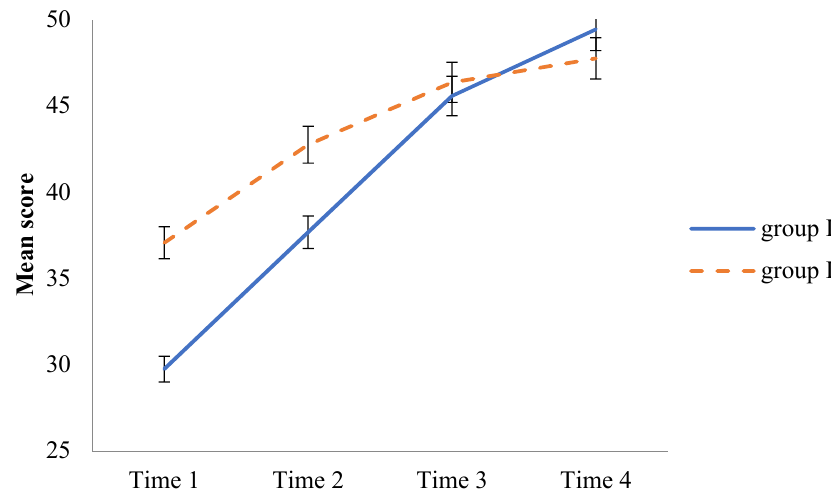
Figure 2. Patterns of scores through four time schedules between Groups I and II.